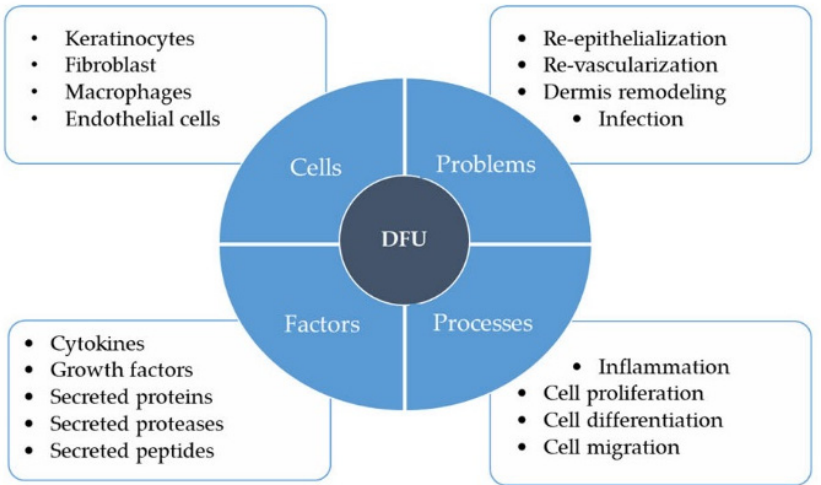
Figure 2. Major factors that contribute to the pathophysiological status of diabetic foot ulcers (DFUs). Keratinocytes, fibroblasts, macrophages, and endothelial cells play important roles in wound healing such as re-epithelialization, revascularization, dermal remodeling, and infection prevention. These functions may be disrupted in the high glucose microenvironment in the skin of diabetic patients, leading to impaired cell proliferation, migration, and di ff erentiation, and prolonged or exaggerated inflammation. Altered cytokine, growth factor, protein, protease, and peptide secretion profiles of di ff erent cell types in the skin in response to high glucose microenvironment further define the pathophysiological status of